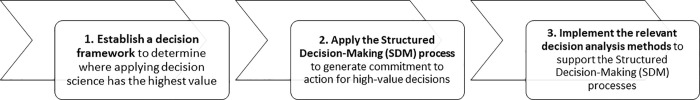
The three-stage approach taken on RRAP to apply lessons from asset-intensive industries to decision-making on the GBR.